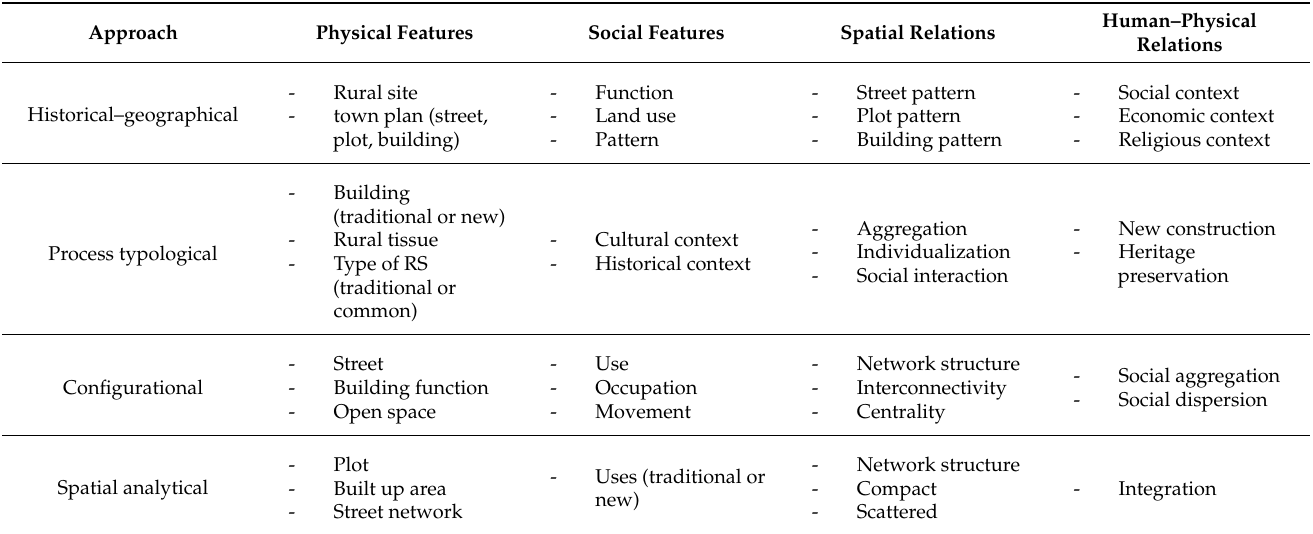
Table 2. Components of the rural settlements and their relationality identified by the different morphological approaches. Source: Adapted from Geddes